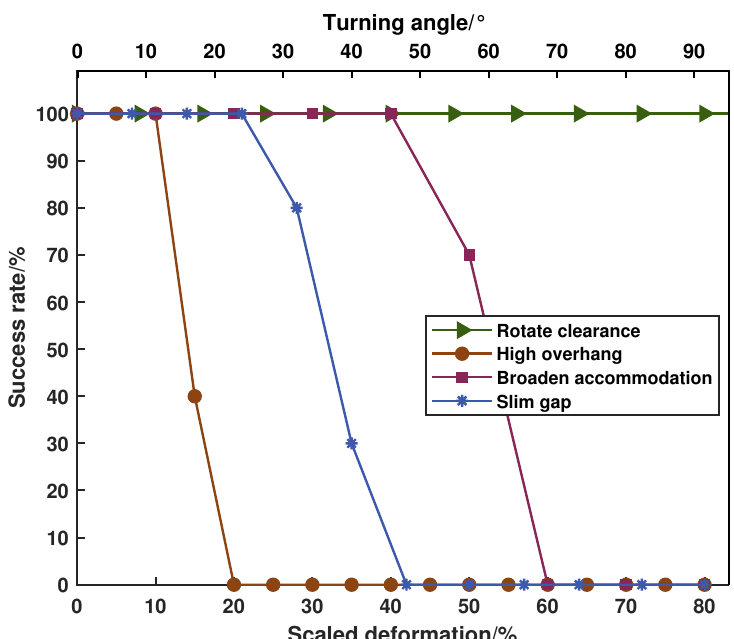
Figure 8. Success rates of increasingly conditional restraints over 10 trials, which are verified in simulation for four specific